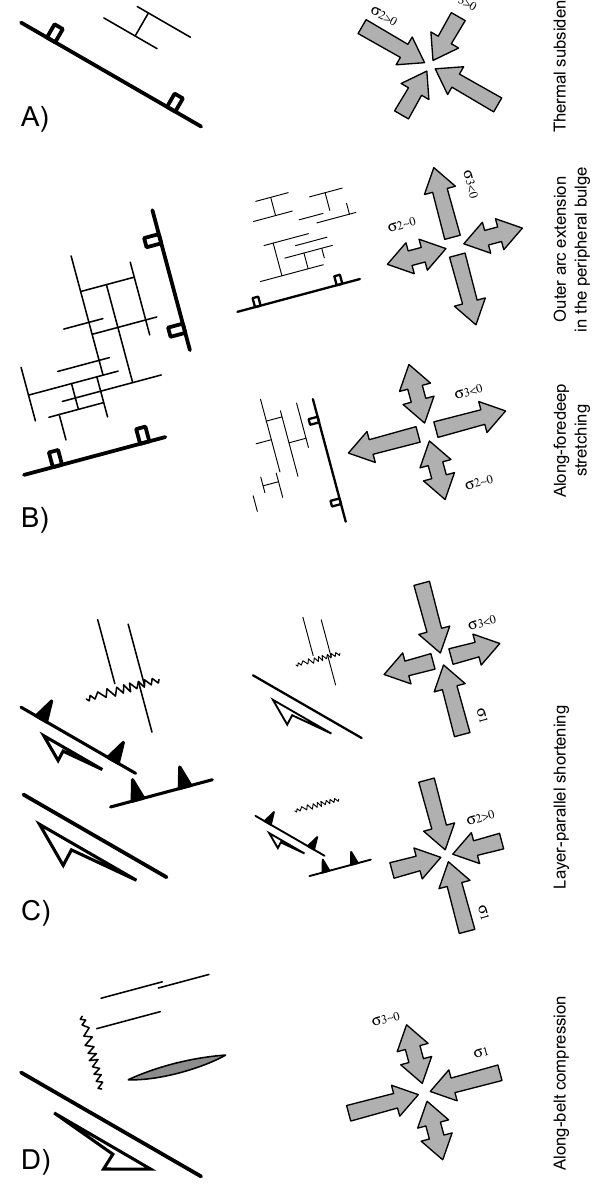
Fig. 12. Fracture patterns, stress fields and associated tectonic events recognised in the Upper Cretaceous limestones of the Plataforma Burgalesa domain and of the Villarcayo syncline, after Quint`a and Tavani (2012). See text for